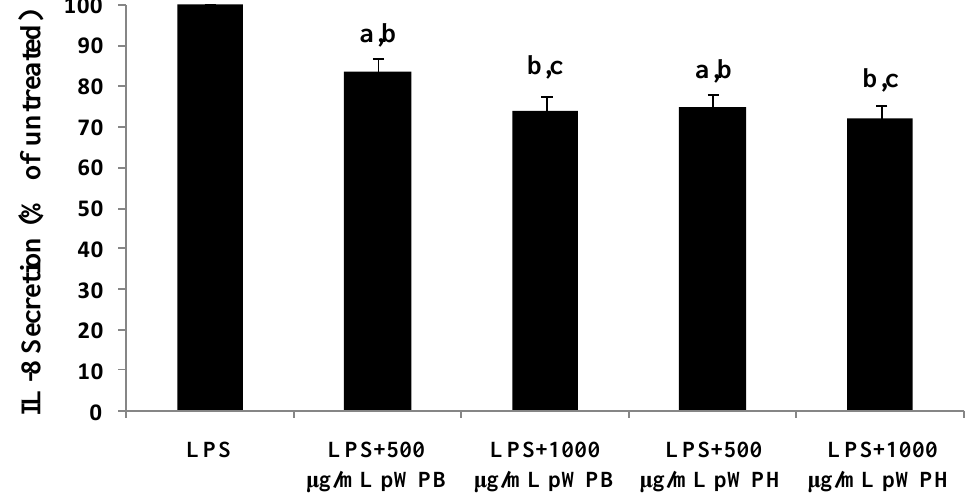
Figure 7. Effect of hydrolysates prepared using two different digestion protocols (pWPH (current protocol) and pWPB (protocol of Vilela et al . (2006) [26]) on LPS-induced